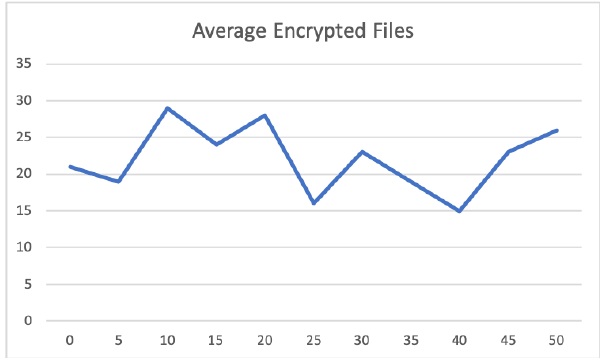
Figure 9. Average number of encrypted